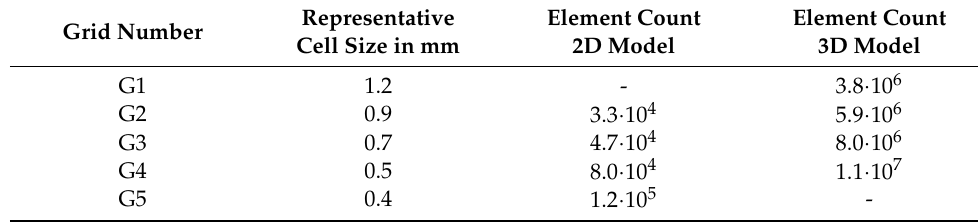
Figure 13. Oscillator position vs. time for different initial positions of the oscillator. Red line—starting from ϕ = 0 ◦ , black line—starting from ϕ = 14 ◦ . Table 4. Mesh independence study